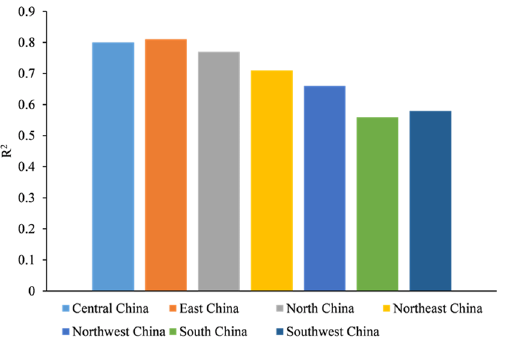
Figure 9. R 2 -based accuracy evaluation of the hybrid model for different geographical regions.